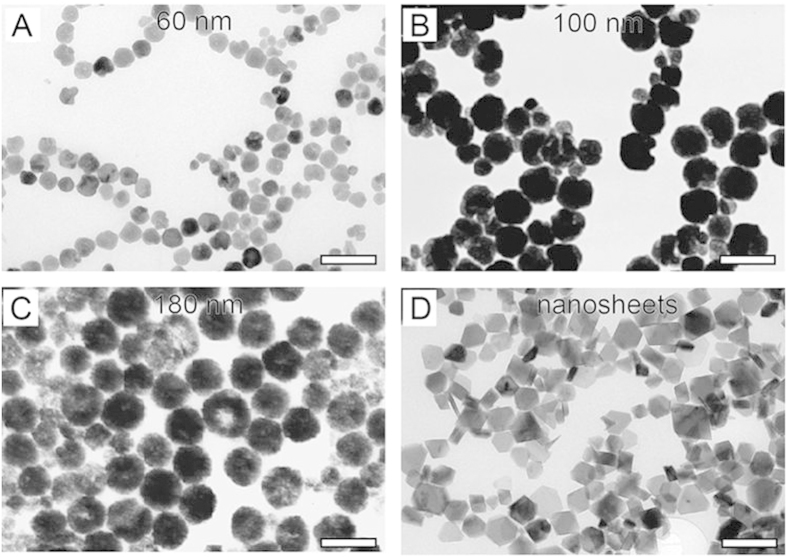
TEM images of (A) 60 nm Fe3O4 spherical particles, (B) 100 nm Fe3O4 spherical particles, (C) 180 nm Fe3O4 spherical particles, and (D) Fe3O4 nanosheets.The scale bars are 200 nm.